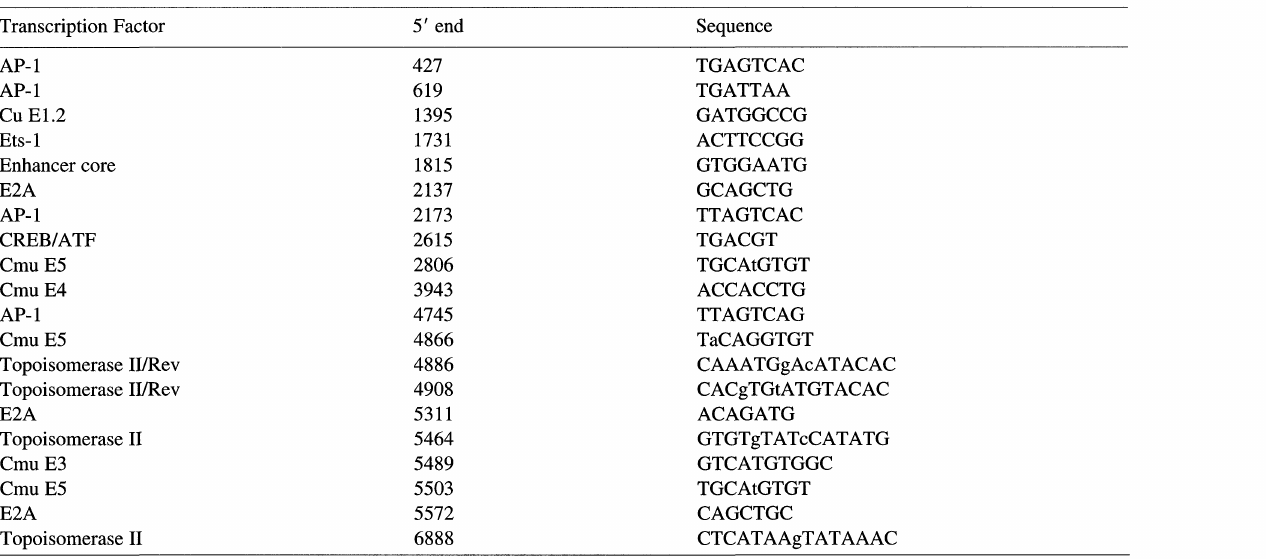
Transcription-Factor Binding Motifs in the Murine RAG Intergenic